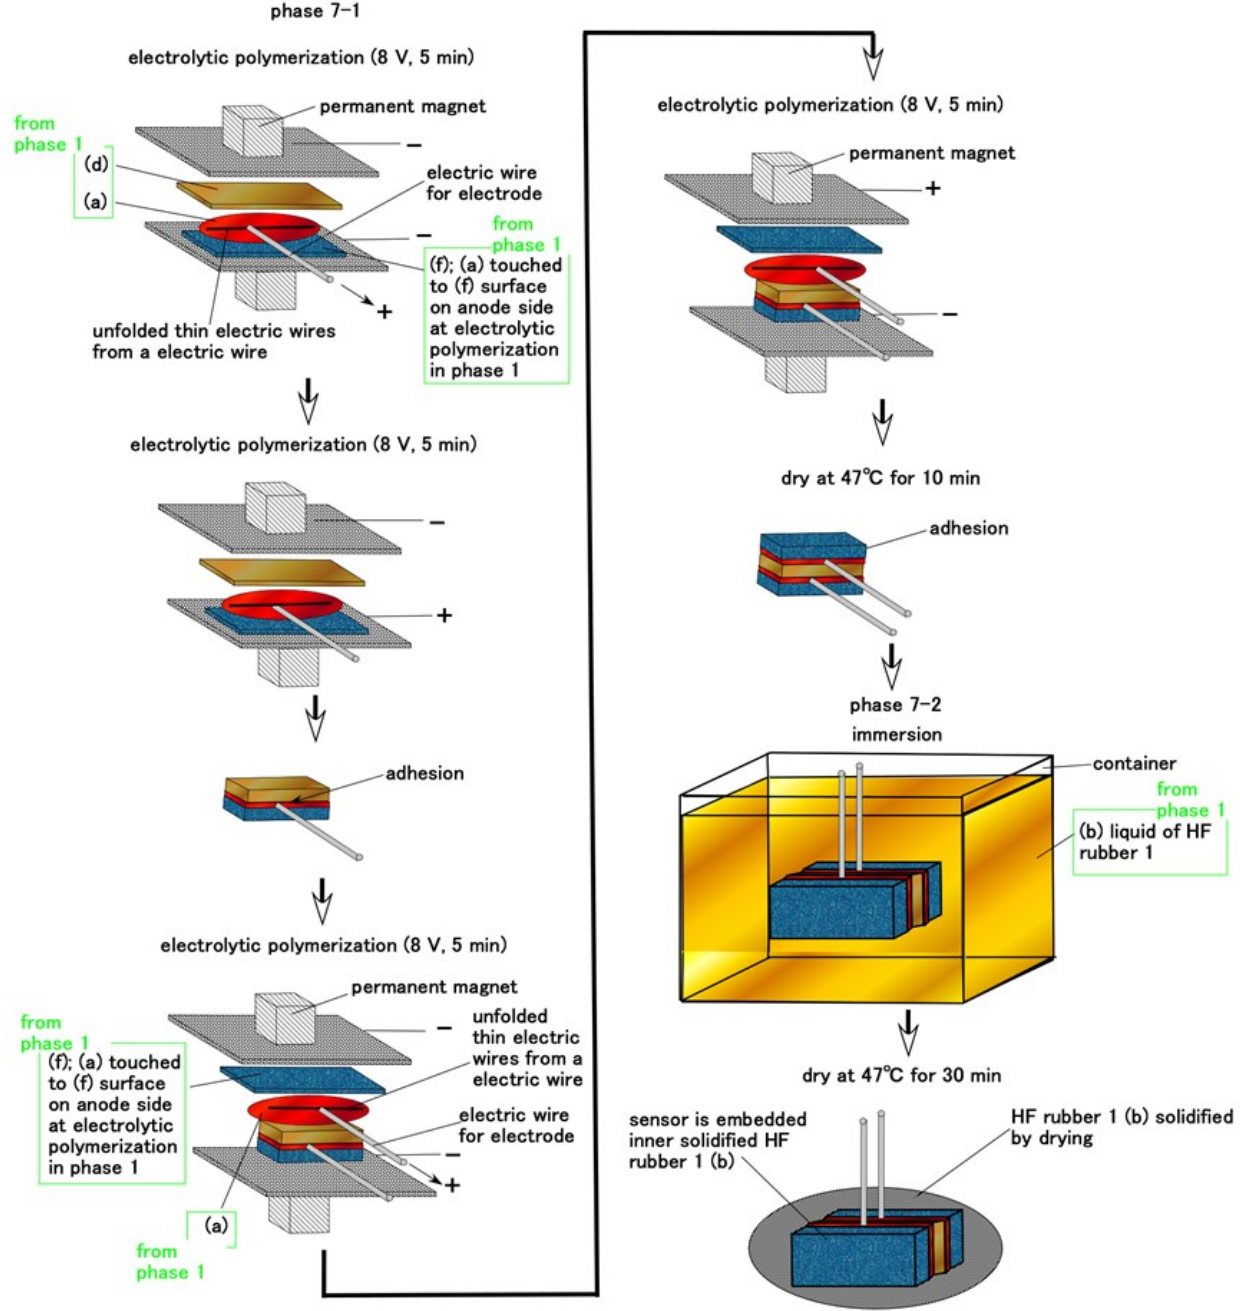
Figure 9. Schematic of the fabrication of Ruffini ending cutaneous receptors during Phase 7. The ultimately fabricated HF sensor in Phases 4-2, 5-2, 6-2, 7-2 is a prerequisite to achieve thorough aridity because of the solidification of U as shown in the following procedure. If the HF sensor is insufficiently dry, U cannot solidify